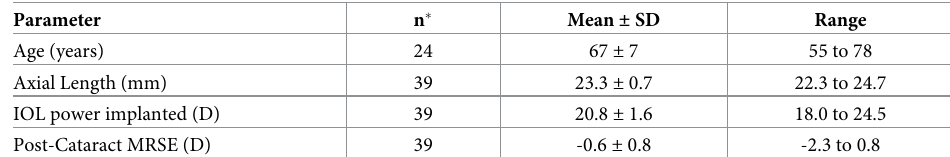
Table 2. Patient